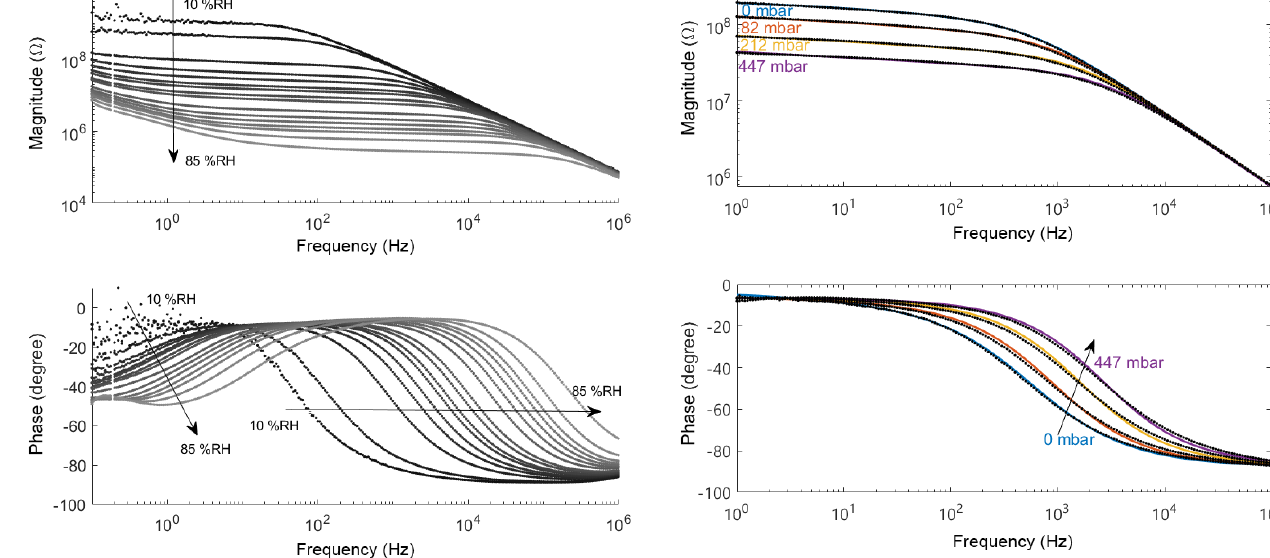
Figure 4. Bode diagram of the sensor at different relative humidity levels at room temperature. The missing datapoint at 188.4mHz in each spectrum is a systematic error and is therefore not plotted for better clarity.